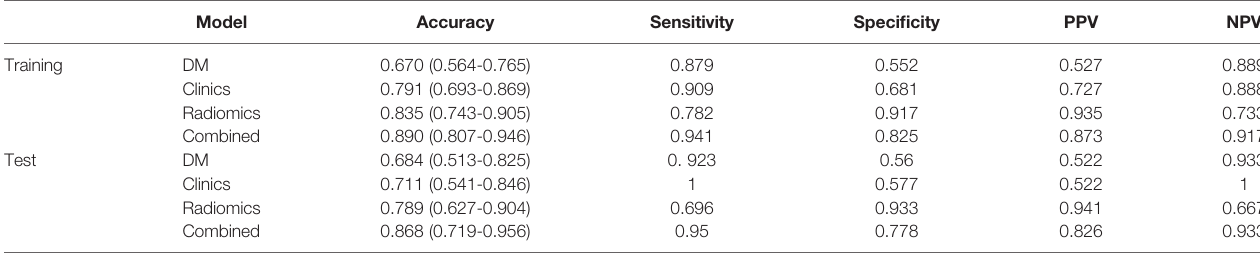
TABLE 5 | Performances of the predictive models in distinguishing benign from malignant tumors.